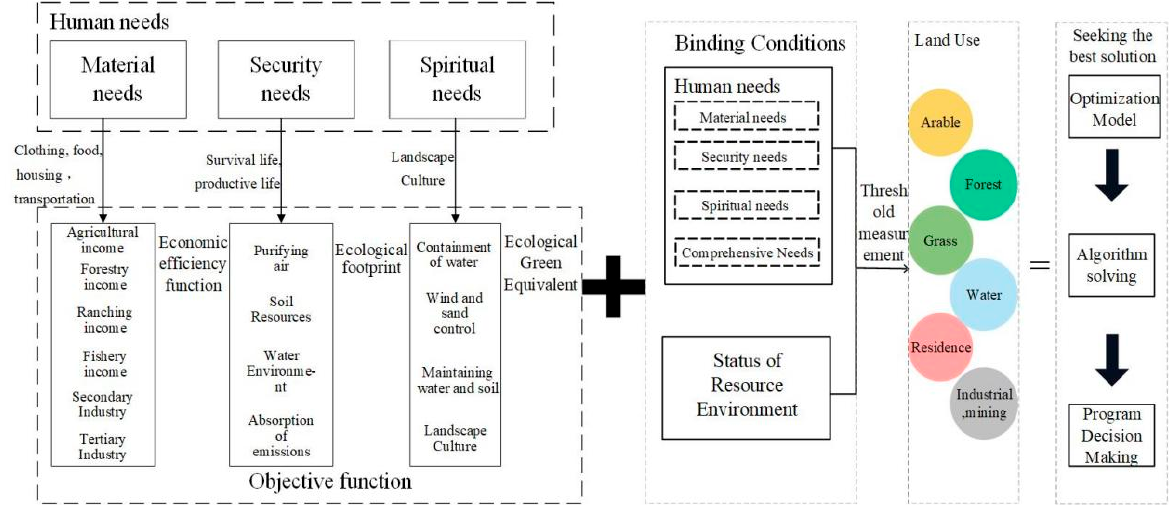
Figure 3. Multi-objective planning flow chart.